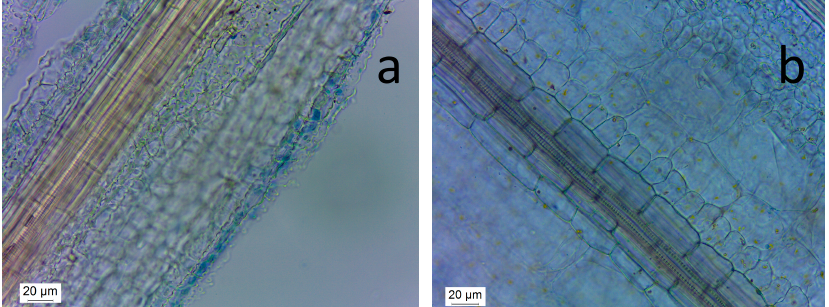
Figure 5. Changes induced by analog 8 in mesophyll cell length in second lamina of rice plants. Longitudinal sections of adaxial sides of the second leaf lamina joint: ( a ) negative control; ( b ) in the presence of analog 8 . Optic Microscope 40×, Scale of bars = 20 µm.